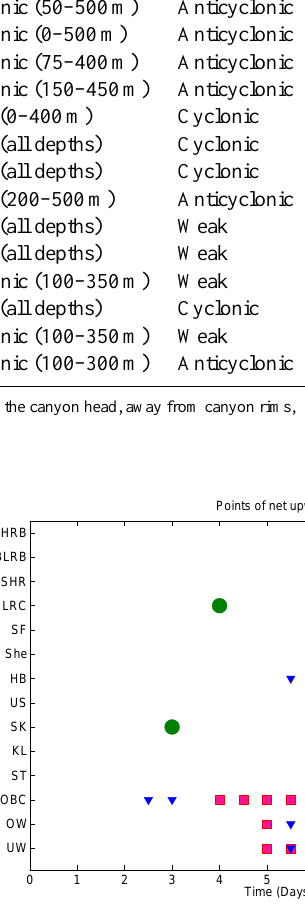
Figure 8. Times of net upwards flux across three vertical planes for all model simulations. Net upwards flux is plotted if larger than a minimum value of 1000m 3 s − 1 − 3